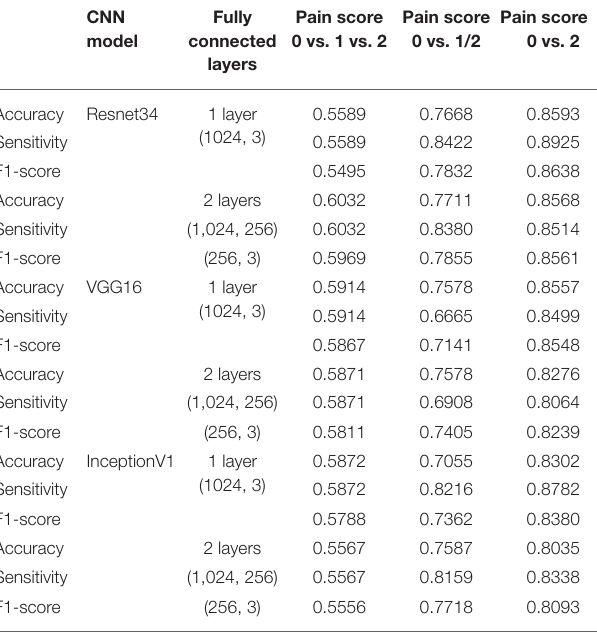
TABLE 1 | Characteristics of the enrolled 63 participants who had videos with all of three pain-score categories. Basic data